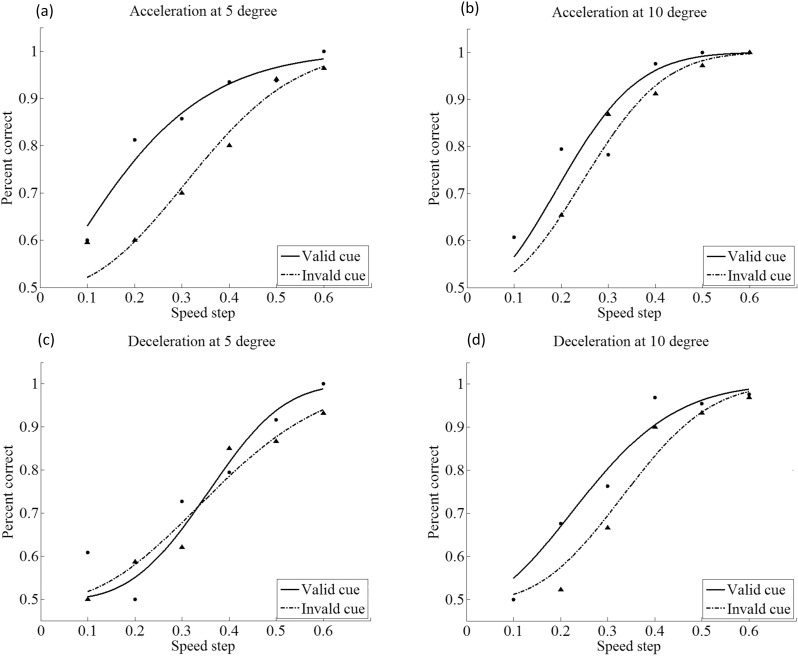
Effects of exogenous attention on performance (percent correctness) as a function of speed change step in Exp1.Solid lines are curve fittings for the valid-cue condition; dashed lines for invalid-cue condition. Acceleration is shown on top panels a and b, and deceleration in bottom panels c and d.